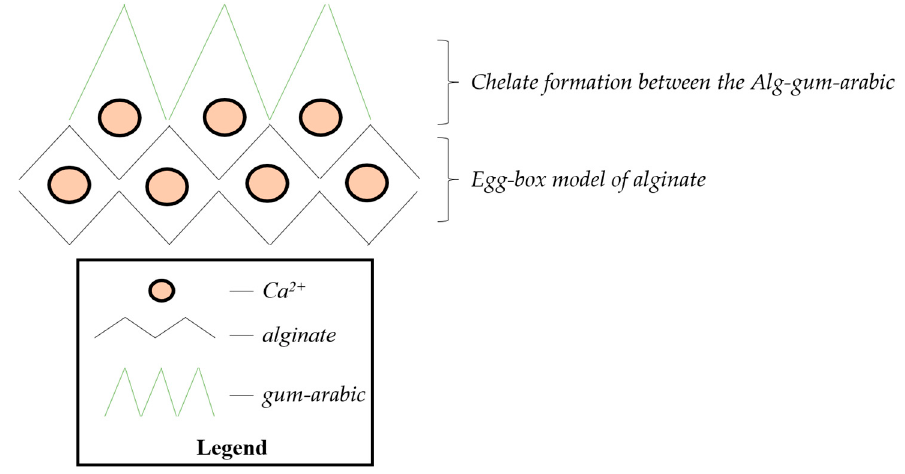
Figure 3. Proposed cross-linking mechanism of the alginate–gum arabic biopolymers.